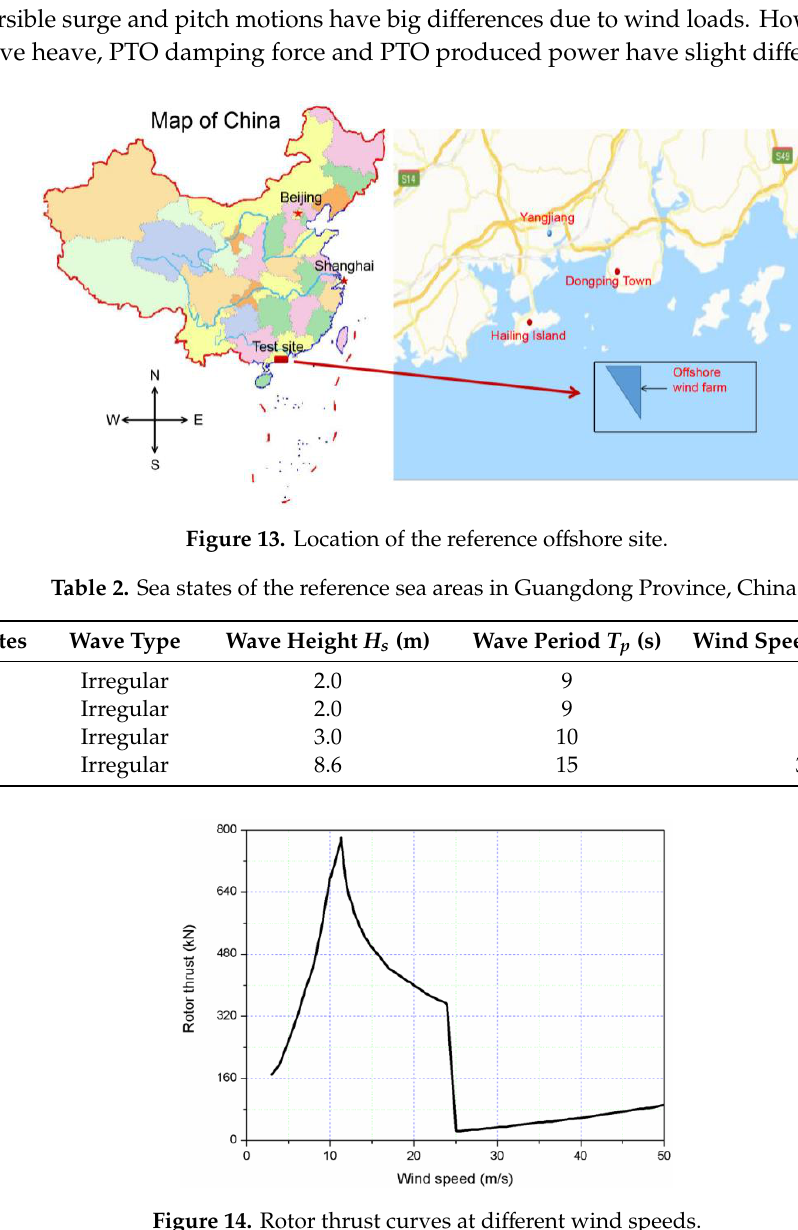
( b ) Figure 12. Responses of the combined structure under different wave heights T = 9 s: ( a ) semisubmersible surge, relative heave and semisubmersible pitch; ( b ) horizontal contact force, damping force and produced power. 4.4.2. Irregular wave and wind conditions